Question: In a single sentence, describe what this figure presents.
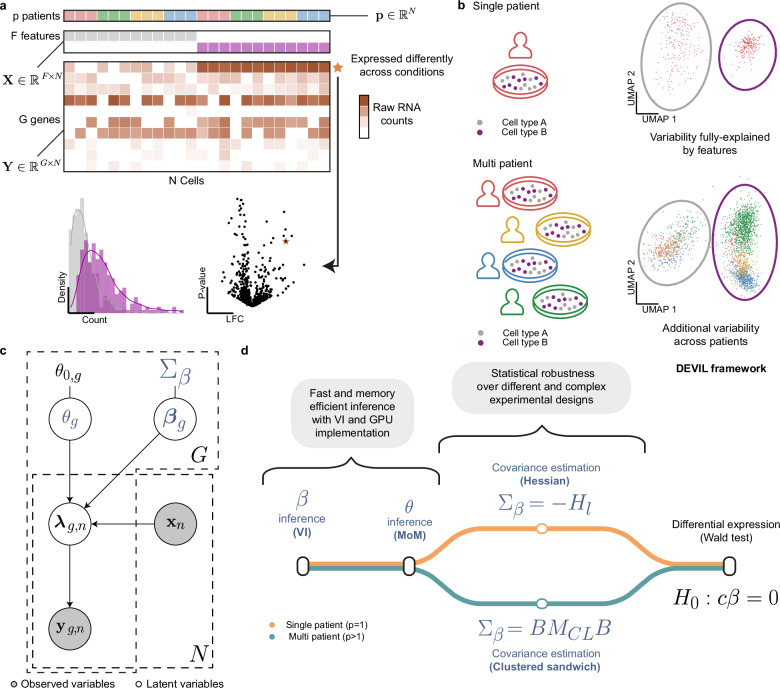
Answer: Multi-patient single-cell differential expression (scDE) testing with DEVIL. a DEVIL operates on three primary inputs: \documentclass[12pt]{minimal} \usepackage{amsmath} \usepackage{wasysym} \usepackage{amsfonts} \usepackage{amssymb} \usepackage{amsbsy} \usepackage{mathrsfs} \usepackage{upgreek} \setlength{\oddsidemargin}{-69pt} \begin{document}$${{{\bf{p}}}}$$\end{document} p denoting patient assignments for each cell, design matrix \documentclass[12pt]{minimal} \usepackage{amsmath} \usepackage{wasysym} \usepackage{amsfonts} \usepackage{amssymb} \usepackage{amsbsy} \usepackage{mathrsfs} \usepackage{upgreek} \setlength{\oddsidemargin}{-69pt} \begin{document}$${{{\bf{X}}}}$$\end{document} X , encoding experimental covariates, and matrix \documentclass[12pt]{minimal} \usepackage{amsmath} \usepackage{wasysym} \usepackage{amsfonts} \usepackage{amssymb} \usepackage{amsbsy} \usepackage{mathrsfs} \usepackage{upgreek} \setlength{\oddsidemargin}{-69pt} \begin{document}$${{{\bf{Y}}}}$$\end{document} Y , containing raw gene expression counts. Gene-level variation is illustrated through a histogram of expression values and a representative volcano plot, which shows log-fold change versus P values, highlighting scDE patterns. b Inter-patient expression heterogeneity challenges scDE testing. UMAP projections illustrate the contrast between single-patient and multi-patient datasets. While single-patient embeddings predominantly reflect intrinsic biological structure (e.g., cell type), multi-patient data introduces additional variation driven by patient-specific factors, underscoring the need for models that disentangle technical and biological sources of variation. c The probabilistic model underlying DEVIL is based on a Gamma–Poisson framework that captures gene-specific overdispersion and population-level effects. Central parameters include gene-wise regression coefficients ( \documentclass[12pt]{minimal} \usepackage{amsmath} \usepackage{wasysym} \usepackage{amsfonts} \usepackag